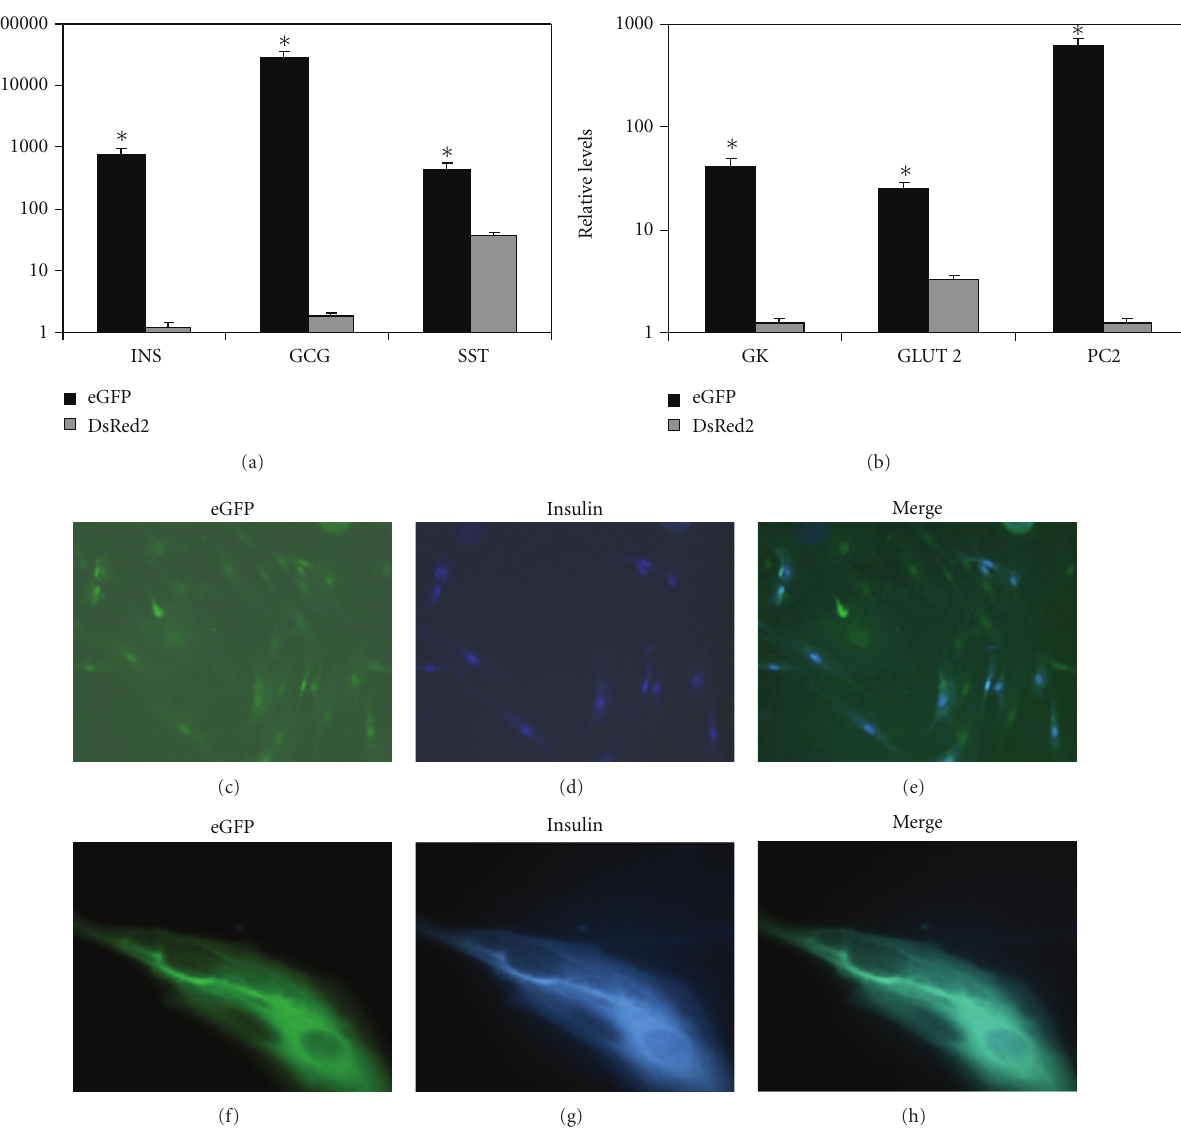
Figure 5: Ectopic PDX-1 expression induced pancreatic di ff erentiation mainly in eGFP positive liver cells. eGFP-positive cells and DsRed2- positive cells were treated with Ad -PDX-1 and soluble factors for 5 days. Quantitative RT-PCR analysis of (a) pancreatic hormones (INS, GG, and SST), and (b) β -cell specific genes (GK, GLUT2, and PC2) in eGFP-positive cells and DsRed2-positive cells ( n = 2 p7–9). The results are normalized to β -actin expression within the same cDNA sample and presented as the relative levels of the mean ± standard deviation of PDX-1 treated cells versus control Ad- β -gal treated cells. ∗ P < 0 . 01. (c–h) Double immunofluorescence analysis of GFP with insulin in Ad -PDX-1 treated eGFP-positive liver cells. Original magnification × 20 (c–e) and × 60 (f–h). Five hundred cells were analyzed under the fluorescent microscope for eGFP, DsRed2, or insulin in three di ff erent